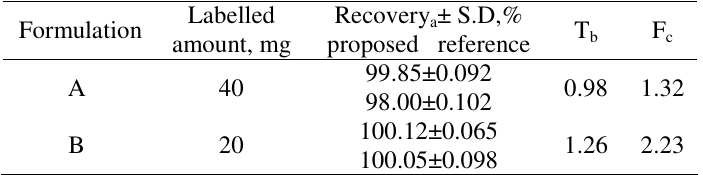
Table 3 . Results of analysis of tablet formulations containing